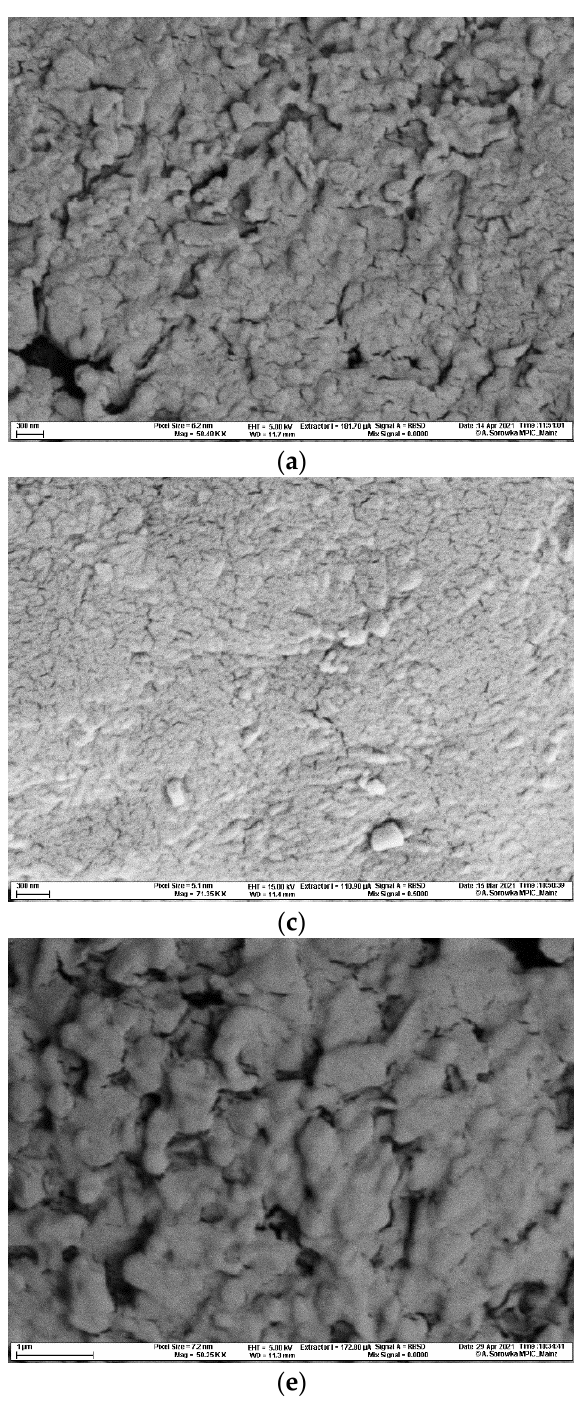
Figure 4. Scanning electron microscope pictures of ( a ) the maltose-based batch (compaction force 40 kN; magnification: 58,480×); ( b ) the mannitol-based batch (compaction force 40 kN; magnification: 129,440×); ( c ) the mannitol/adipic acid- based batch (compaction force 25 kN; magnification: 71,350×); ( d ) the lactose-based batch (compaction force 40 kN; mag- nification: 53,490×); ( e ) the dextrates based-batch (compaction force 40 kN; magnification: 50,250×).The analysis confirmed that pores were of the sizes expected based on the mercury porosity measurement.